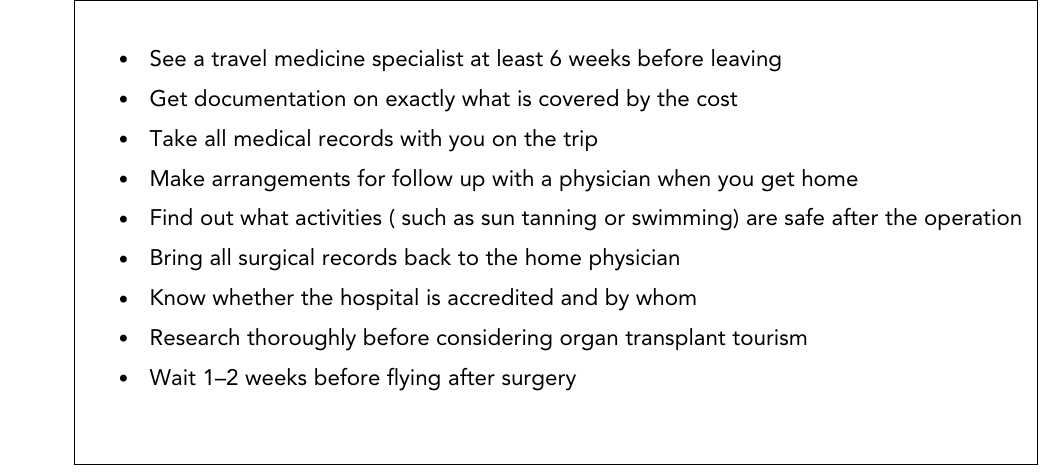
Box 1. Recommendations for medical touring patients